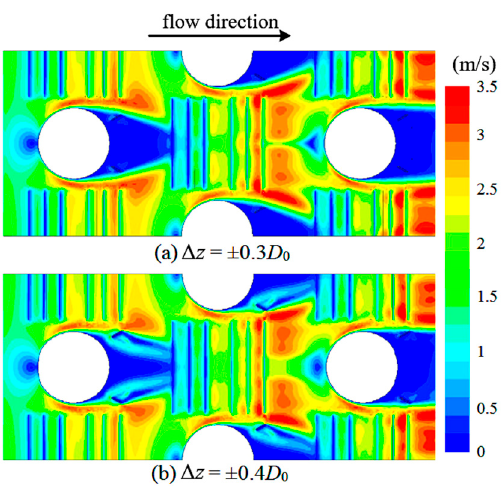
Figure 14. Velocity contours in a compound fin with louvre and DWPs for V in = 1.26 m/s [95].